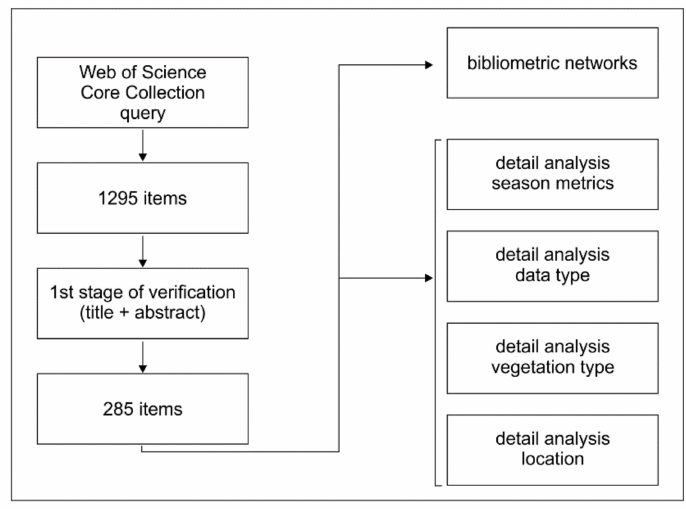
Figure 1. Procedure scheme—creation of a database and analysis of articles.